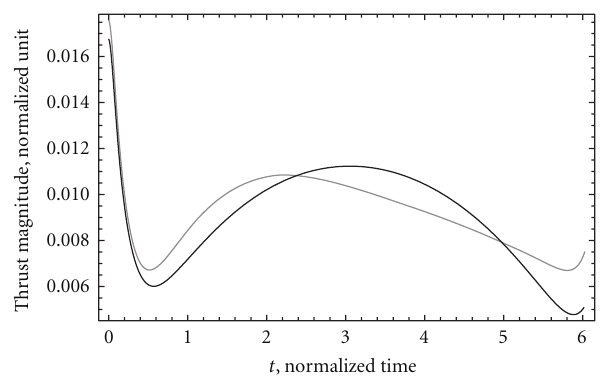
Figure 3: Thrust magnitude comparison of di ff erent trajectories in case B.